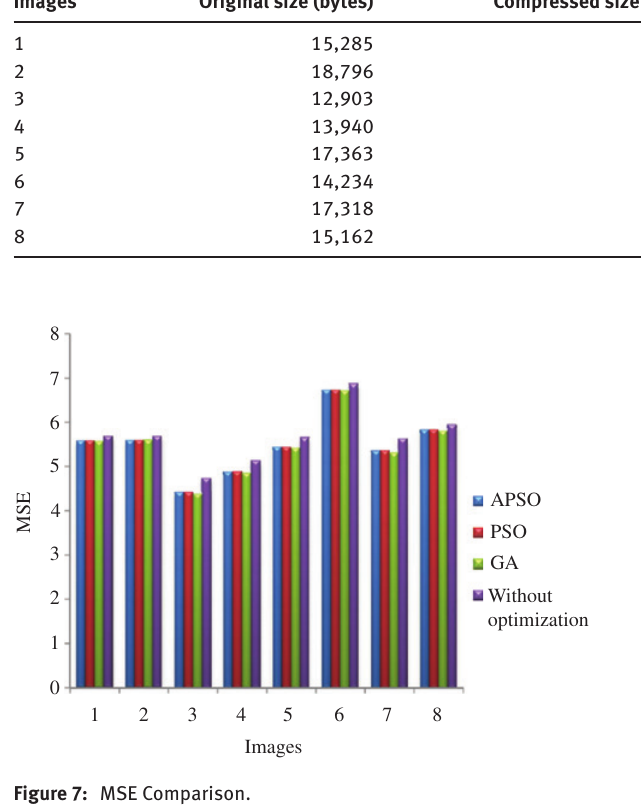
Figure 7: MSE Comparison.